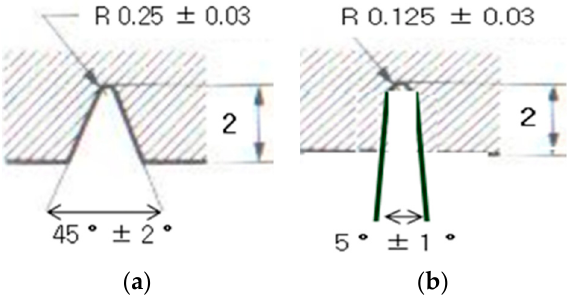
Figure 2. ( a ) Notch shape of the standard V-type impact specimen (Korean Standards (KS) specification); ( b ) sharp I-type notch impact specimen (unit: mm) proposed by the author [17]. The notch shape of the impact specimen was precisely machined using a wire